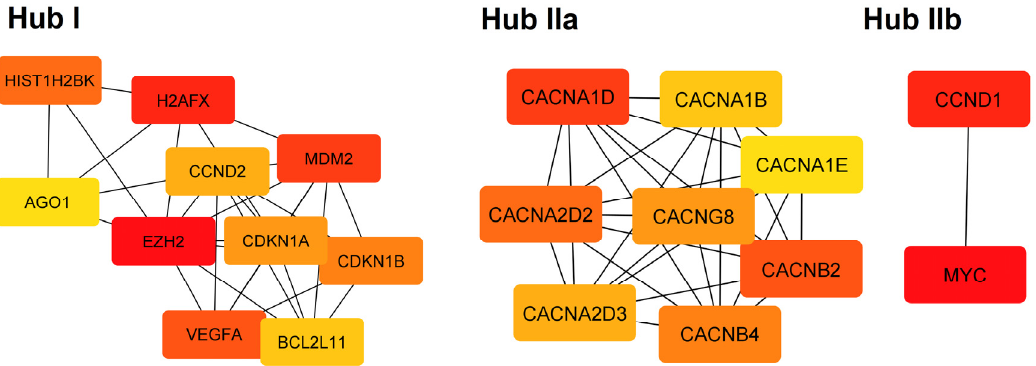
Figure 9. The PPI hub gene modules from PPI networks of the genes regulated by downregulated (Hub I) and upregulated miRNAs (Hubs IIa, IIb). Table 6. Enrichment analysis of the hub gene module from the PPI network of the genes regulated by downregulated and upregulated miRNAs.